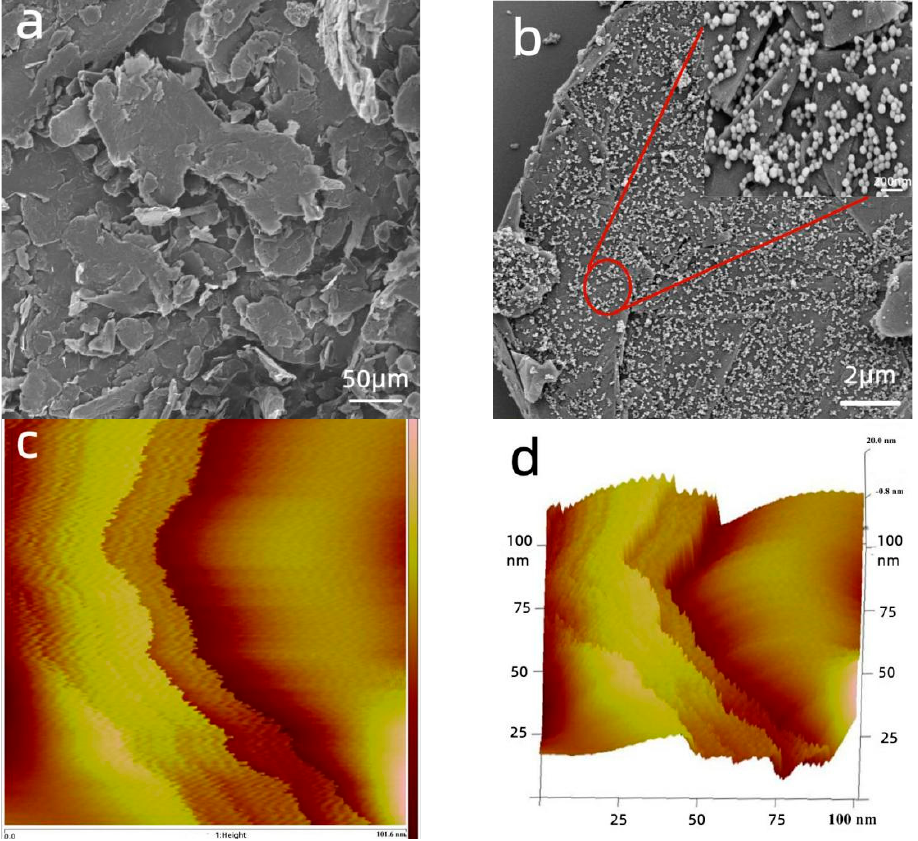
Figure 3. SEM images of the samples: ( a ) MGO, and ( b ) MGO@ZIF-8; and AFM images of the samples: ( c ) MGO@ZIF-8, and ( d ) MGO@ZIF-8.